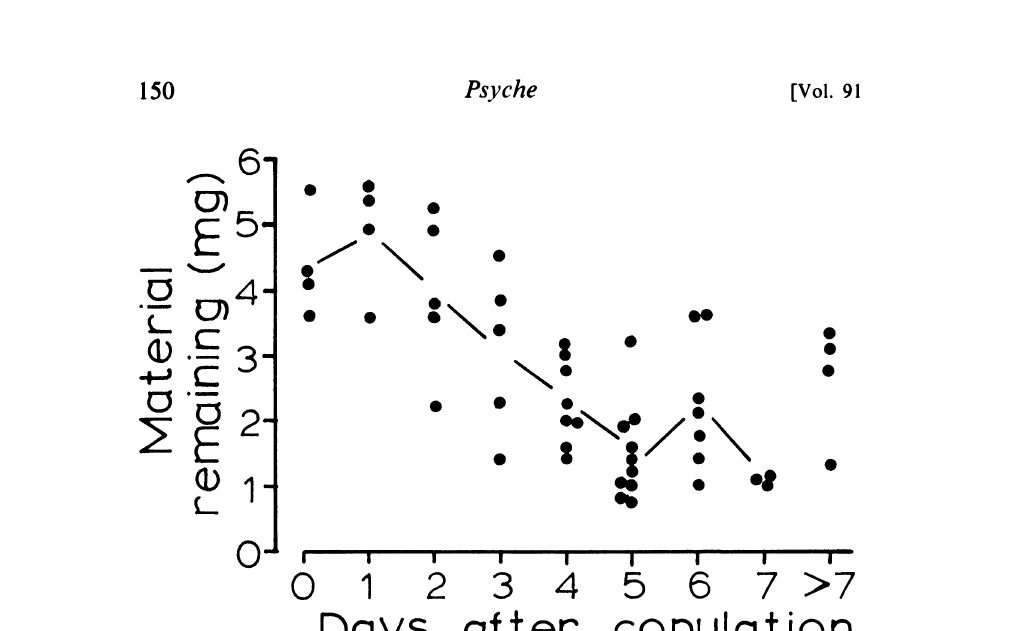
Figure 4. The quantity of material.remaining in the female’s bursa copulatrix as a function of the time since copulation. Line shows change in mean values for days 0 through